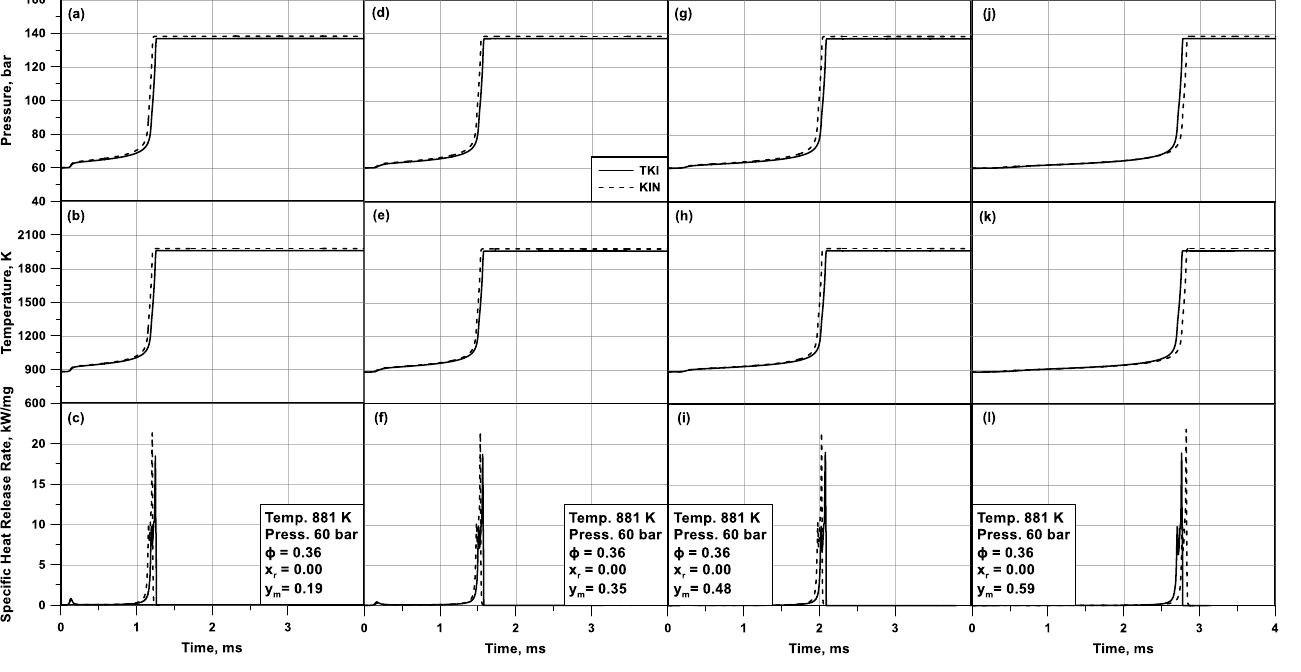
Figure 5. Comparisons of pressure ( a , d , g , j ), temperature ( b , e , h , k ), and heat release rate ( c , f , i , l ) between the online chemical kinetics (KIN, the dashed line) and the TKI approach (TKI, the continuous line) for different mixtures of n-heptane/toluene/ethanol.